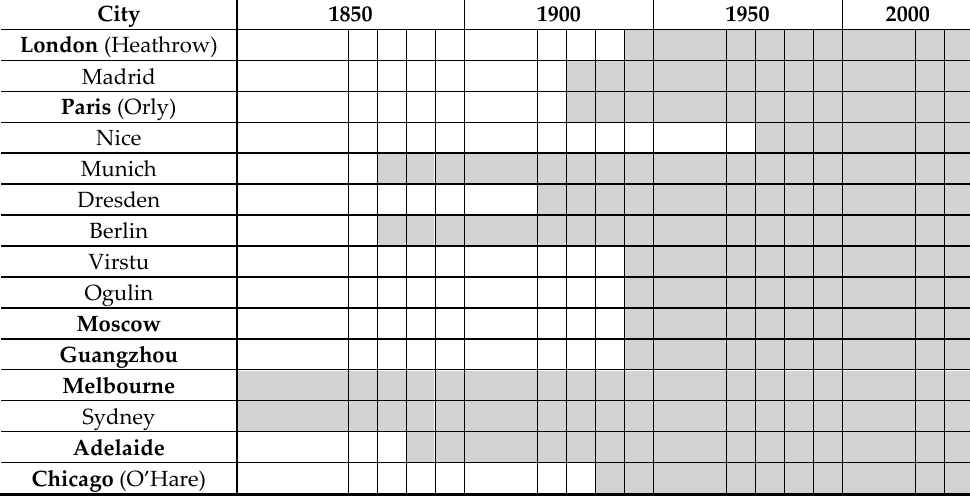
Table 1. Excess Heat Factor ( EHF ) intensity and severity calculated for the observation period shown in grey bars for each site. Cities in bold are examined in detail in Section 3.